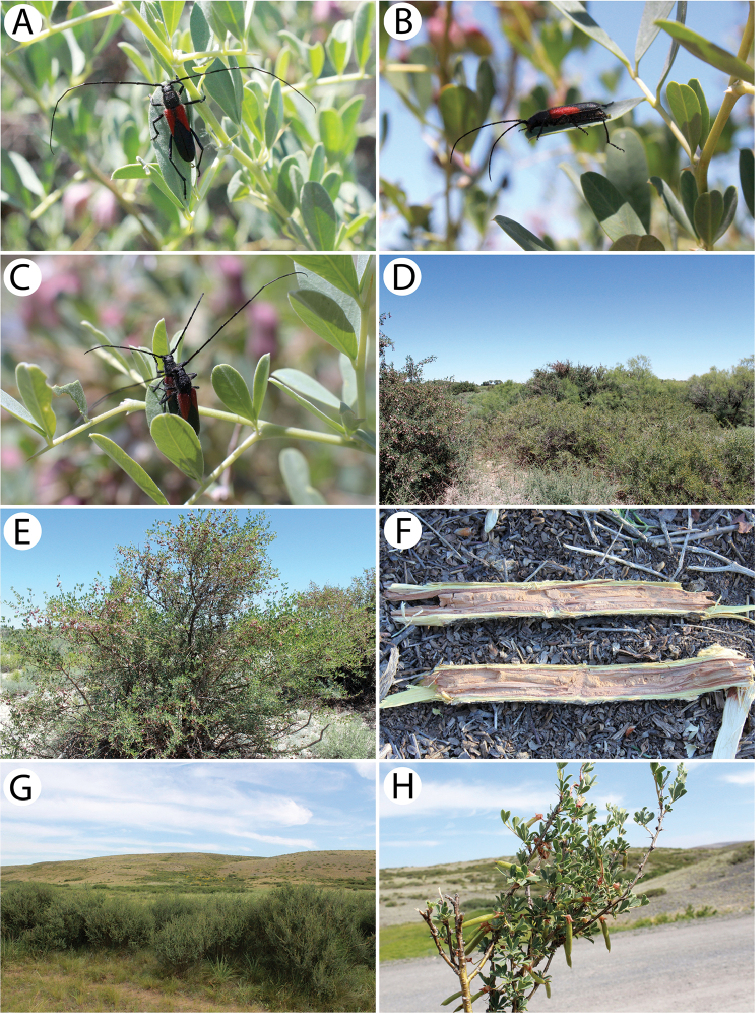
Field photos of imagines in nature, host plants and habitats of typical Kazakh cerambycid species: A male of AnoplistesjacobsoniB female of A.jacobsoniC pair of A.jacobsoni in copula on HalimodendronhalodendronD tugays with Halimodendron, Tamarix and Eleagnus in Tartogay environs, the habitat of A.jacobsoni and ChlorophoruselaeagniE shrub of H.halodendron, the host plant of A.jacobsoniF larval feeding gallery of A.jacobsoni in a stem of H.halodendronGCaragana shrubs in Tarbagatay environs, the habitat of AnoplisteshalodendrihalodendriHCaragana sp., the host plant of A.halodendrihalodendri.